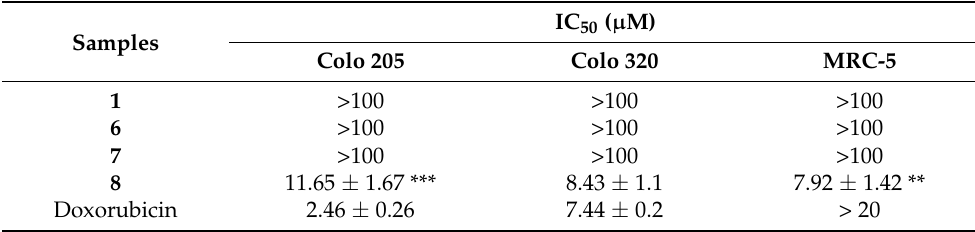
Table 4. Cytotoxic activity of compounds 1 , 6 – 8, and doxorubicin on the human colon adenocarci- noma cell lines (sensitive Colo 205 and resistant Colo 320 cells) and on the normal MRC-5 embryonal fibroblast cell